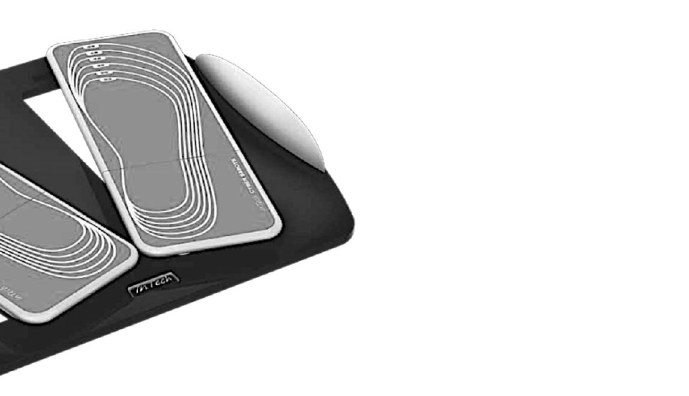
Figure 1. Lumbar, ankles and feet manipulation techniques.